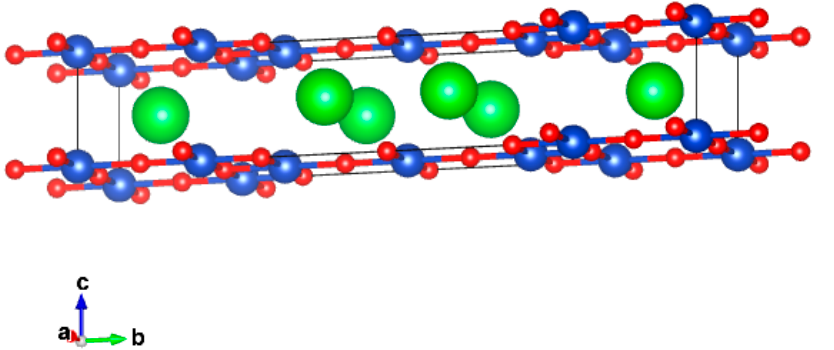
Figure 6. Crystal structure of Sr 4 Cu 6 O 10 . Sr, Cu and O atoms are shown by green, blue and red circles, respectively .